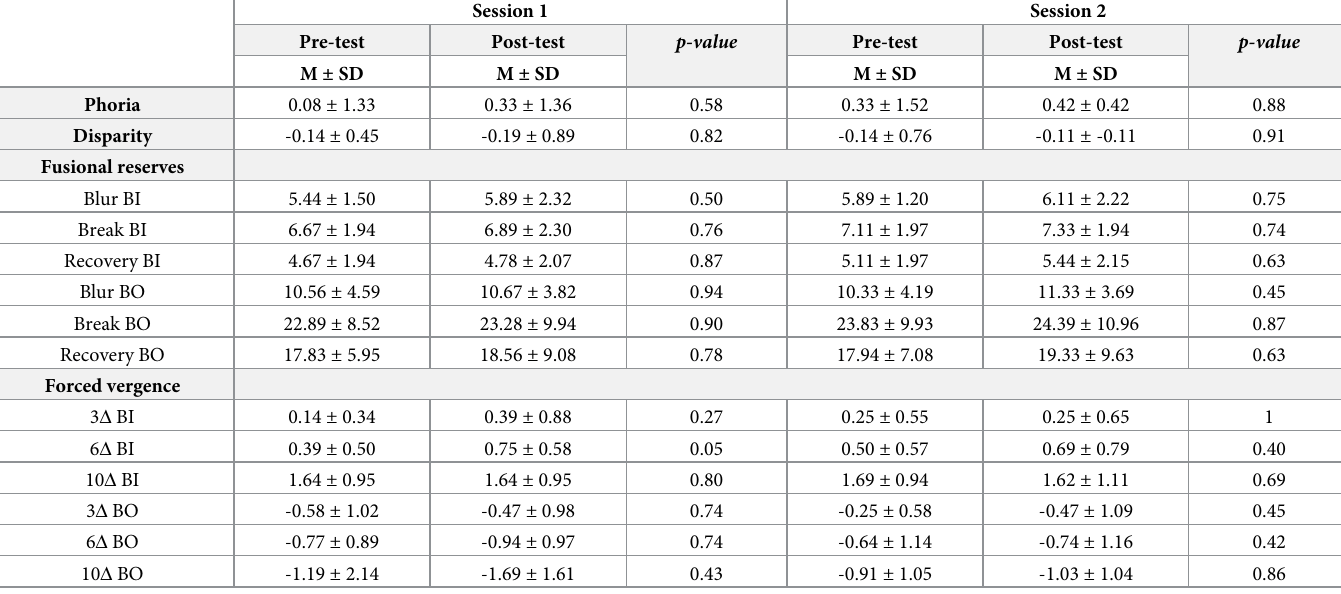
Table 3. Results and statistical analyses before and after each of the three optometric tests in the two sessions.